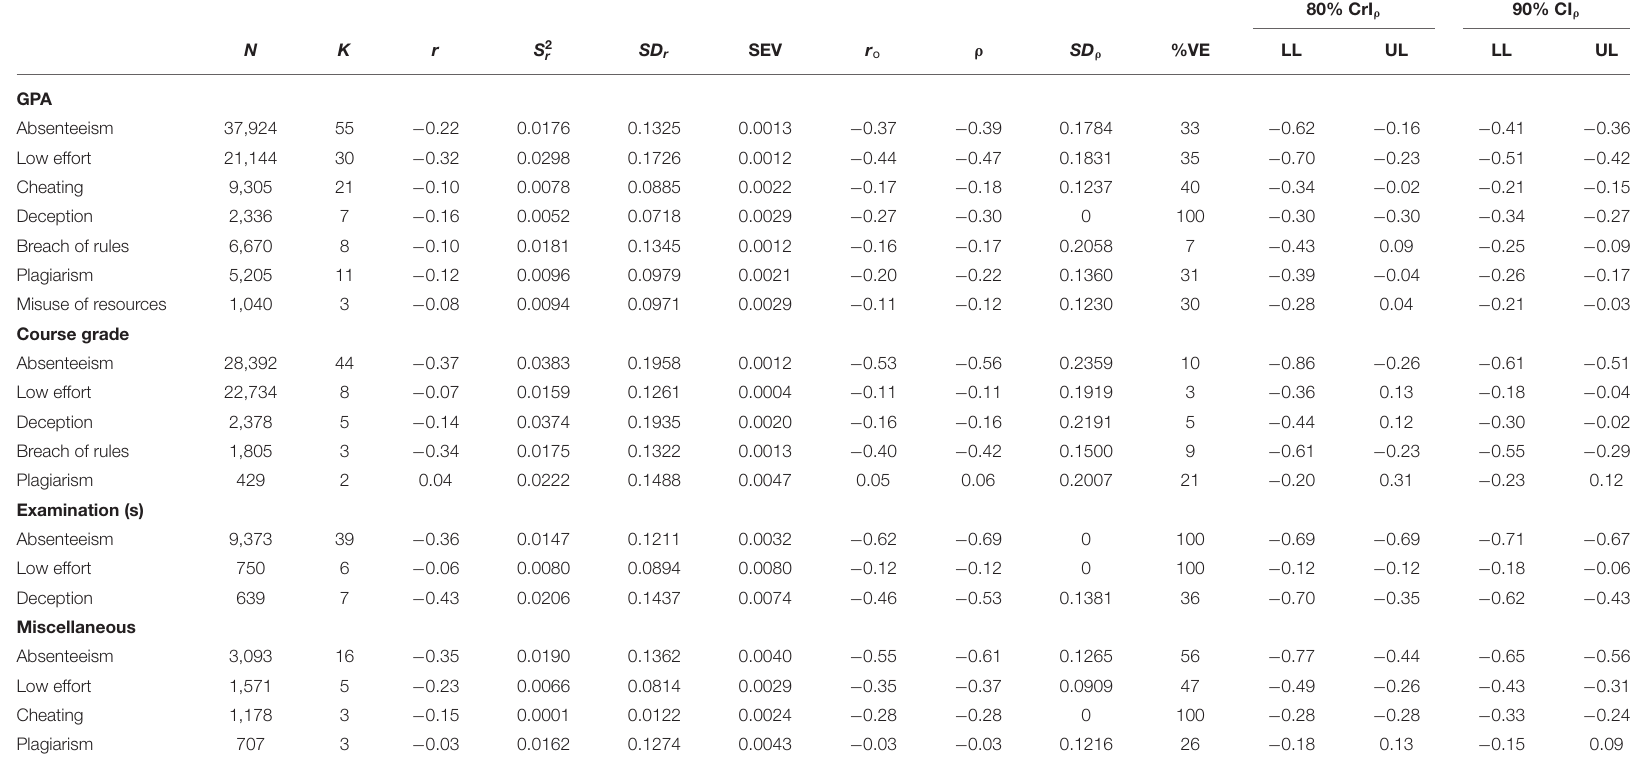
TABLE 4 | Hierarchical meta-analyses of the CAB-AP relationship according to the CAB facets and to the type of AP